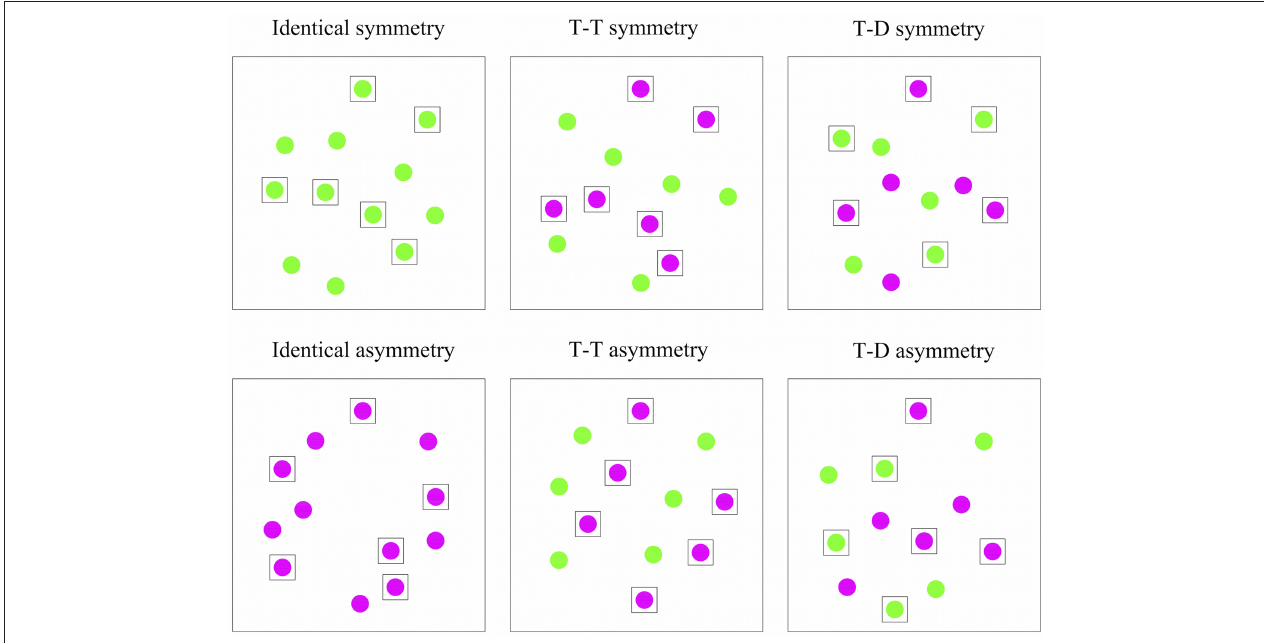
FIGURE 6 | Stimuli for Experiment 3. Six conditions classified by the grouping relation based on symmetry and color. Disks inside the black squares were targets.